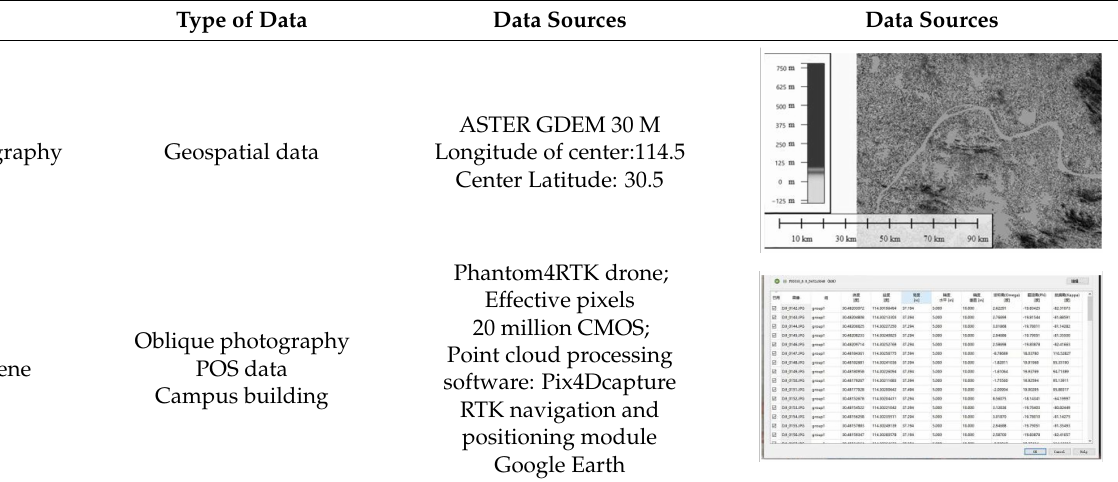
Table 1. Static scene